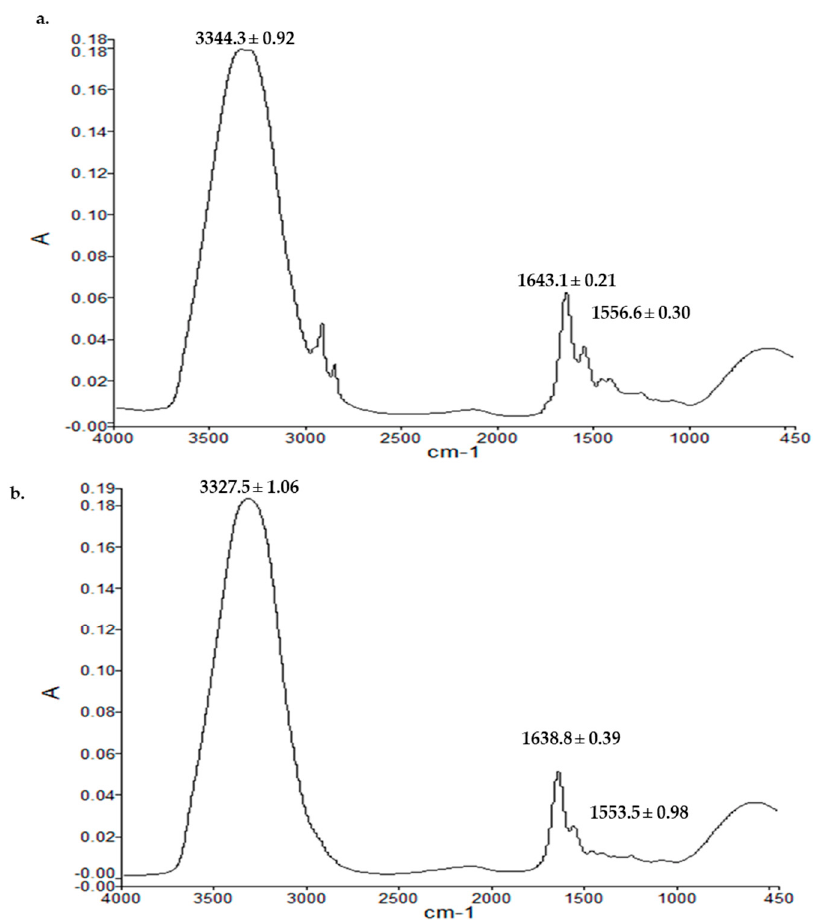
Figure 10. ATR-FTIR spectra of the dermis of ( a ) untreated skin and ( b ) film-treated skin.